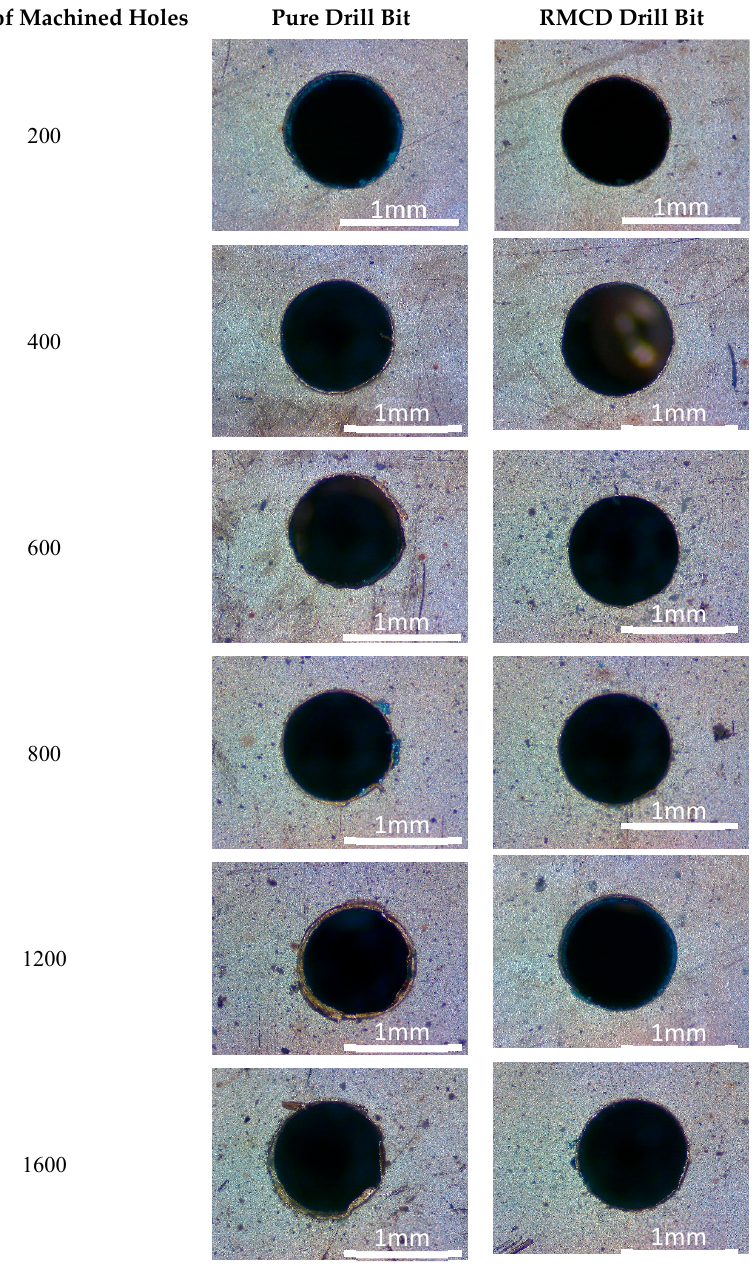
Figure 5. Shapes of the machined holes by the pure and RMCD drill bits.